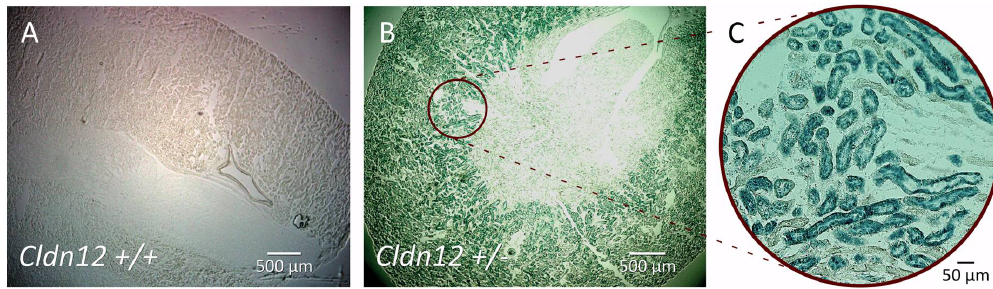
Figure 2. X-gal staining of kidney sections from wild type ( A ) and heterozygous ( B ) mice. β- galactosidase is expressed in the renal cortex in knockout kidney slices and not in wild type ones. Higher power image ( C ).